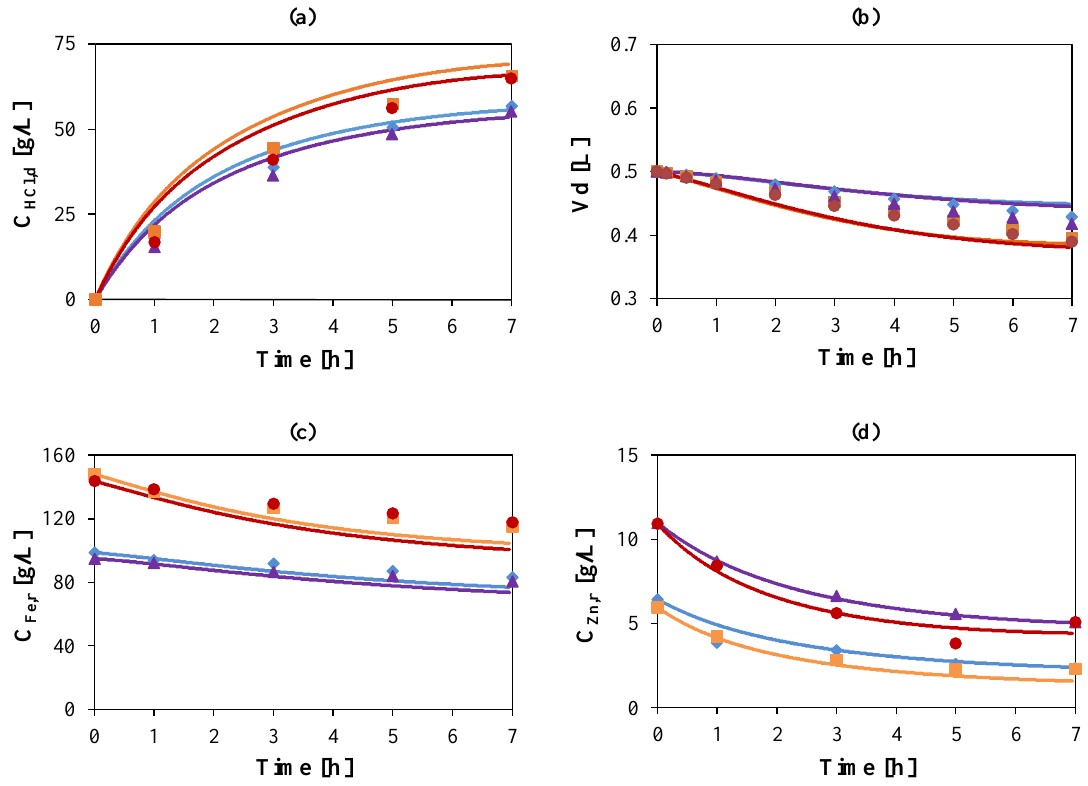
Figure 6. HCl concentration in diffusate ( a ), diffusate volume ( b ), Fe concentration in retentate ( c ) and Zn concentration in retentate ( d ) vs. time. Initial Zn concentrations: 5 ( ♦ , ) and 10 ( , ) g/L. Initial Fe concentrations: 100 ( ♦ , ) and 150 ( , ) g/L. Initial acid concentrations: 73 g/L (2 mol/L). Flow rate: 48 ml/min. Feed: HCl, FeCl 2 , ZnCl 2 solution. Diffusate IN: deionized water. Theoretical curves (—) obtained by using the model.